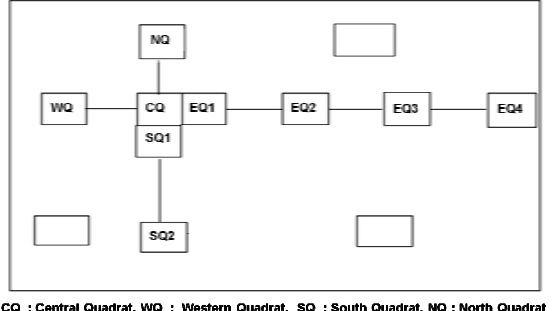
Figure 1. Sampling design for measurements